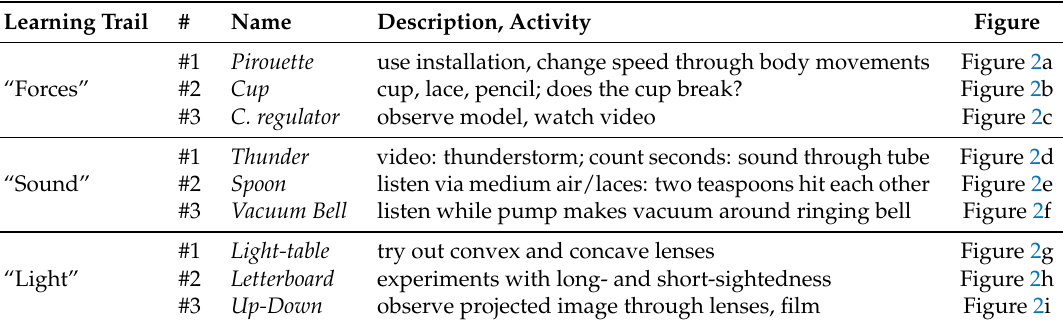
Table 2. List of experiments of the learning trails and reference to illustration image Learning